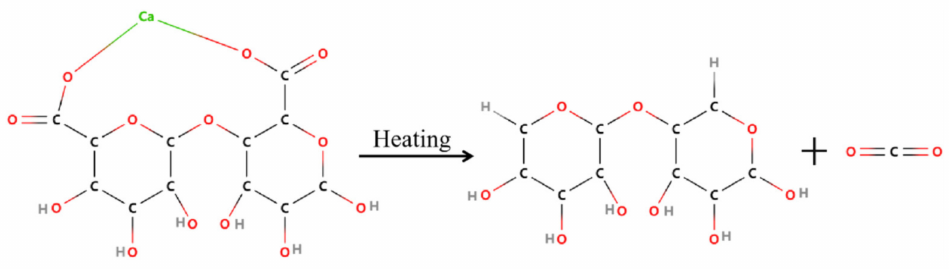
Figure 12. Schematic diagram of thermal decomposition of alginate fiber.